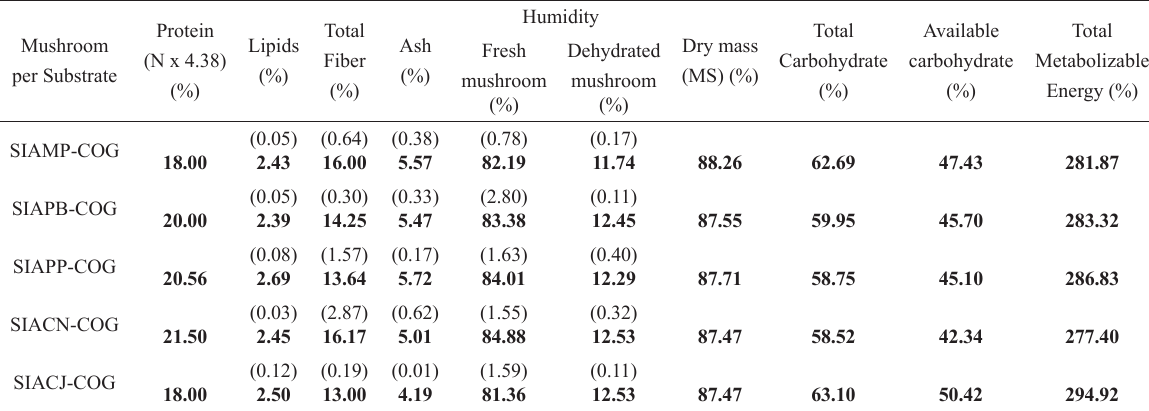
Result of the centesimal composition of Lentinus strigosus in different substrates.